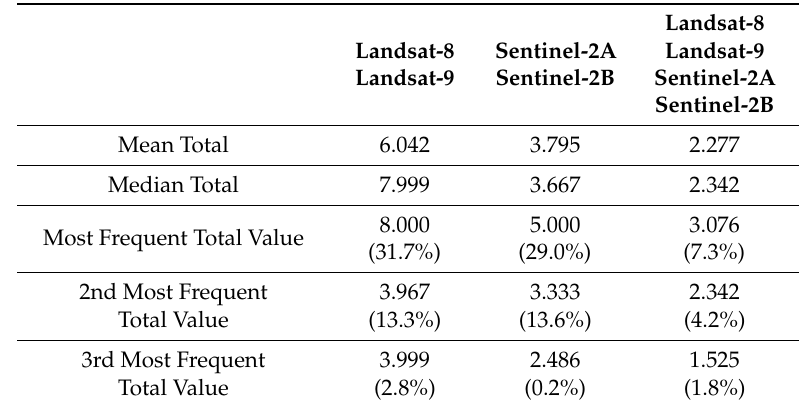
Figure 2. Global average revisit interval histograms divided into 20-min bins for combinations of ( a ) Landsat-8 and Landsat-9, ( b ) Sentinel-2A and Sentinel-2B, and ( c ) Landsat-8, Landsat-9, Sentinel-2A and Sentinel-2B from 1 January to 31 December 2016. The percentages denote the percent of each bin compared with the total number of revisits. All data are from Figure 1. Table 1. Global statistics including mean, median and various modes for combinations of (a) Landsat-8 and Landsat-9, (b) Sentinel-2A and Sentinel-2B, and (c) Landsat-8, Landsat-9, Sentinel-2A and Sentinel-2B from 1 January to 31 December 2016. Results are given to three decimal places. Percentages for each mode are tabulated. All data are from Figure 1.